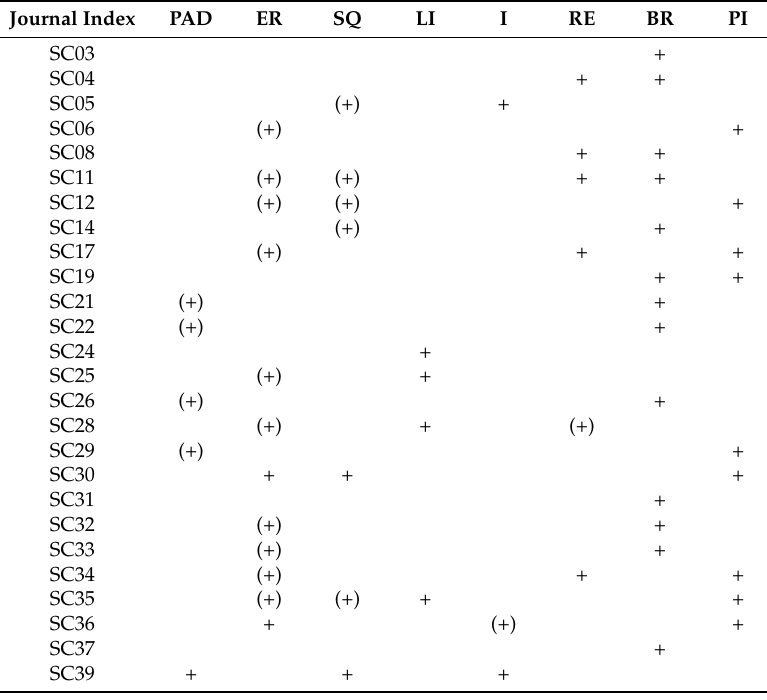
Table 4. Framework of servicescapes (frequencies of independent, mediating and moderating